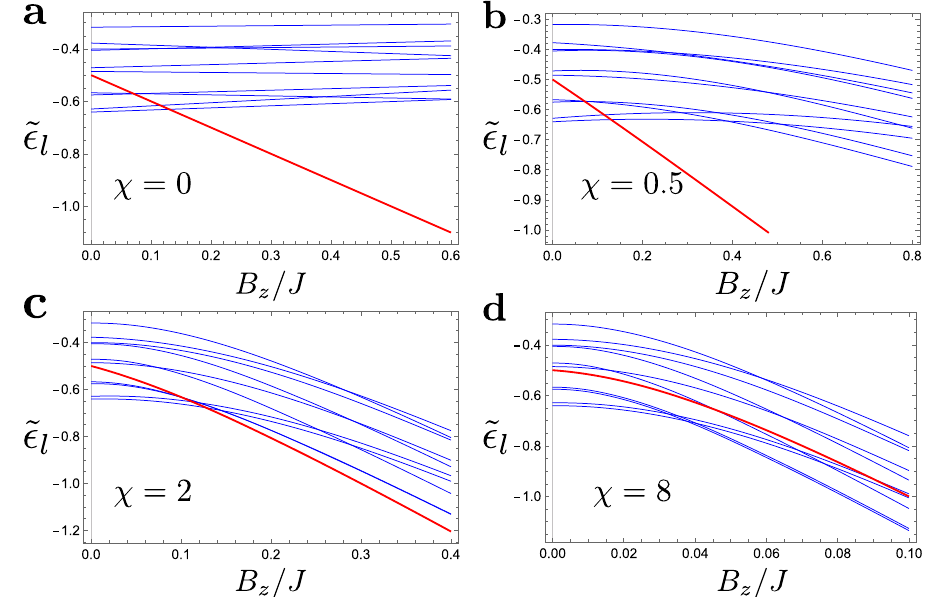
Fig.3|Spectraofisolatedlocalminima. Spectraofisolatedlocalminima,shown in blue, for a χ = 0, b χ = 0.5, c χ = 2, and d χ = 8, within the same realization. As χ increases, a progressively larger fraction of higher energy states curves down